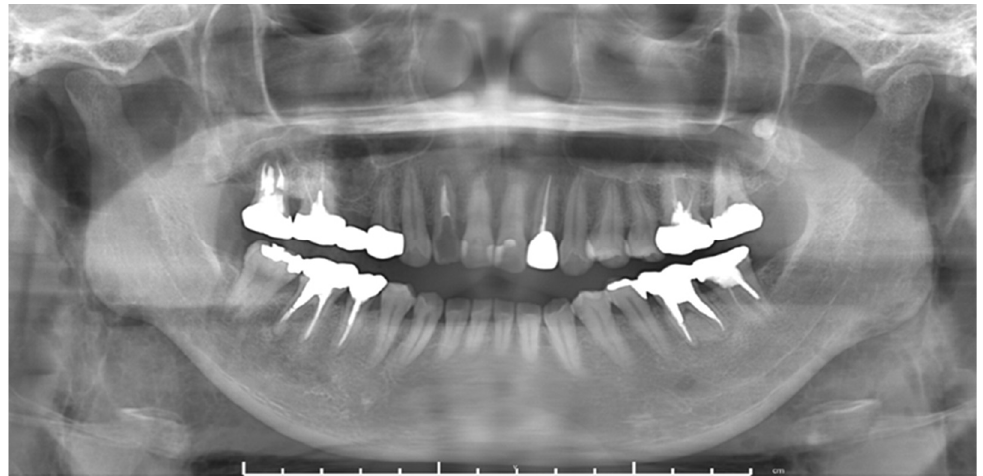
Figure 3. Panoramic radiograph at the first visit. Table 1. CT at the first visit. The spread of emphysema to the tissue gap in cases 1–3 is shown separately at the facial, cervical, and mediastinal levels; this shows the air volume in the 3D model on the initial visit and 3rd day after the